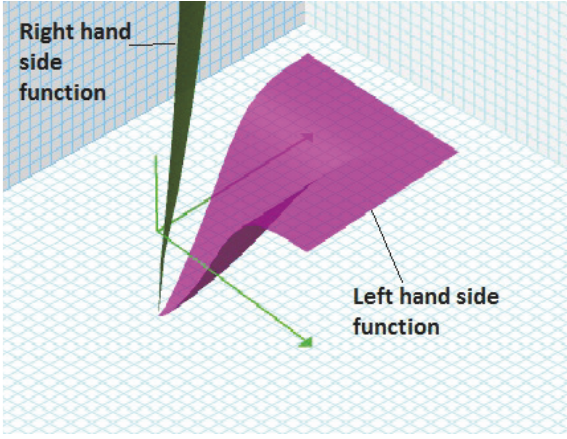
Figure 3: Right hand side function superimposes left hand side